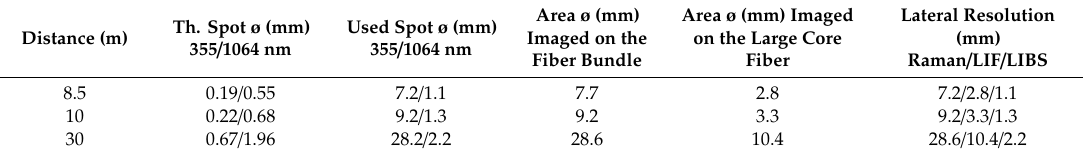
Table 2. The minimum theoretical laser spot size for three target distances, the used laser spot size, and the lateral resolution for Raman, LIF and LIBS